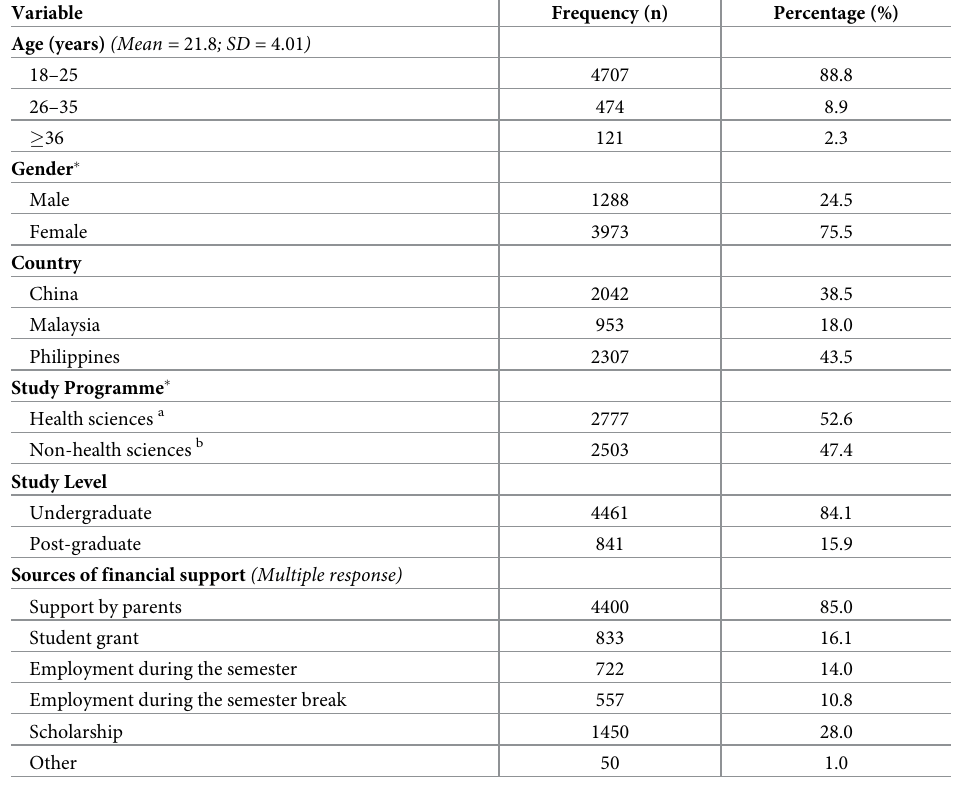
Table 1. Demographic variables of the university students from China, Malaysia, and the Philippines (n = 5302).